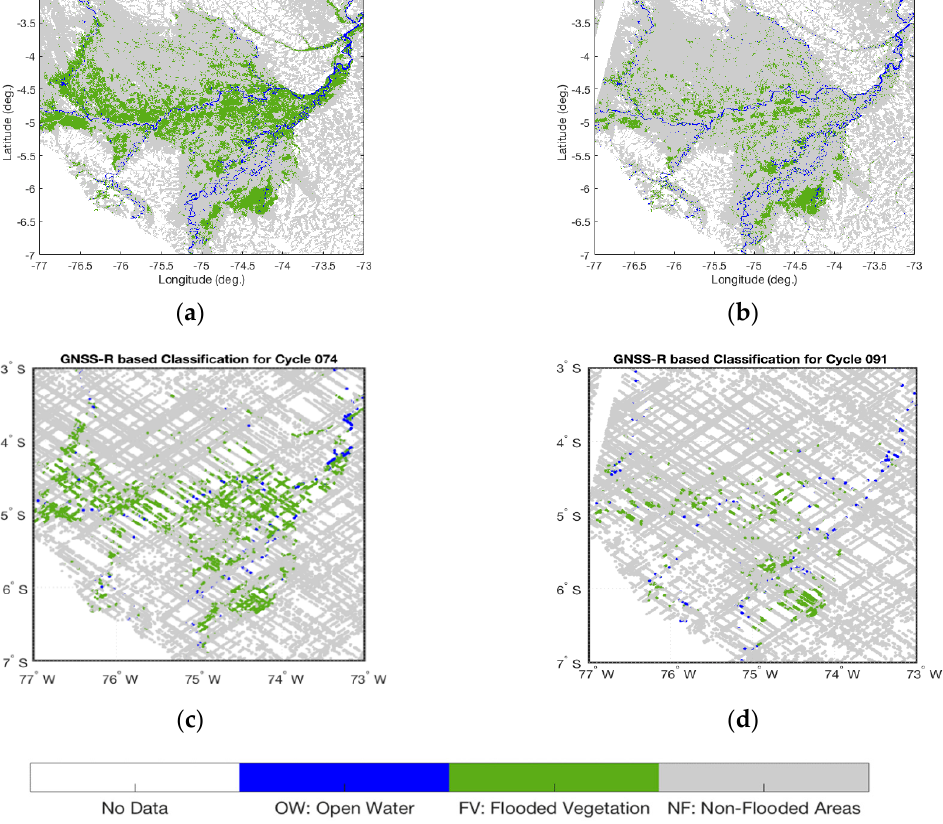
Figure 9. Inundation classification of Pacaya-Samiria using the MDTR algorithm. In the top row, PALSAR-2-based inundation maps used as reference for ( a ) cycle 74 during the end of the high-flood season and ( b ) for cycle 91 during the end of the low-flood season. In the bottom row, GNSS-R inundation classification results for the same seasonal cycles: ( c ) cycle 74 and ( d ) cycle 91. For display purposes only, we are showing the CYGNSS results at approximately 3 km.